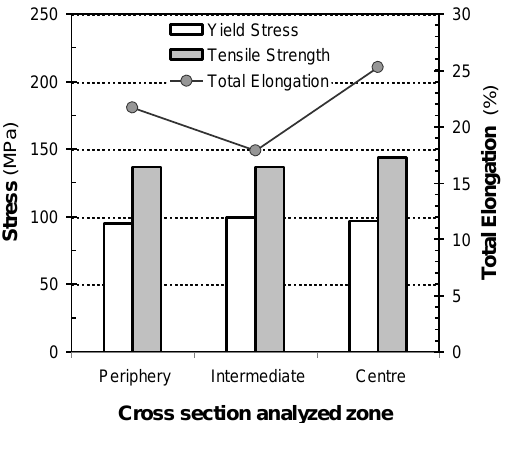
Figure 6. Tensile test results of the as-homogenized billet at three locations: periphery, intermediate and center. Tensile specimens machined parallel to the billet